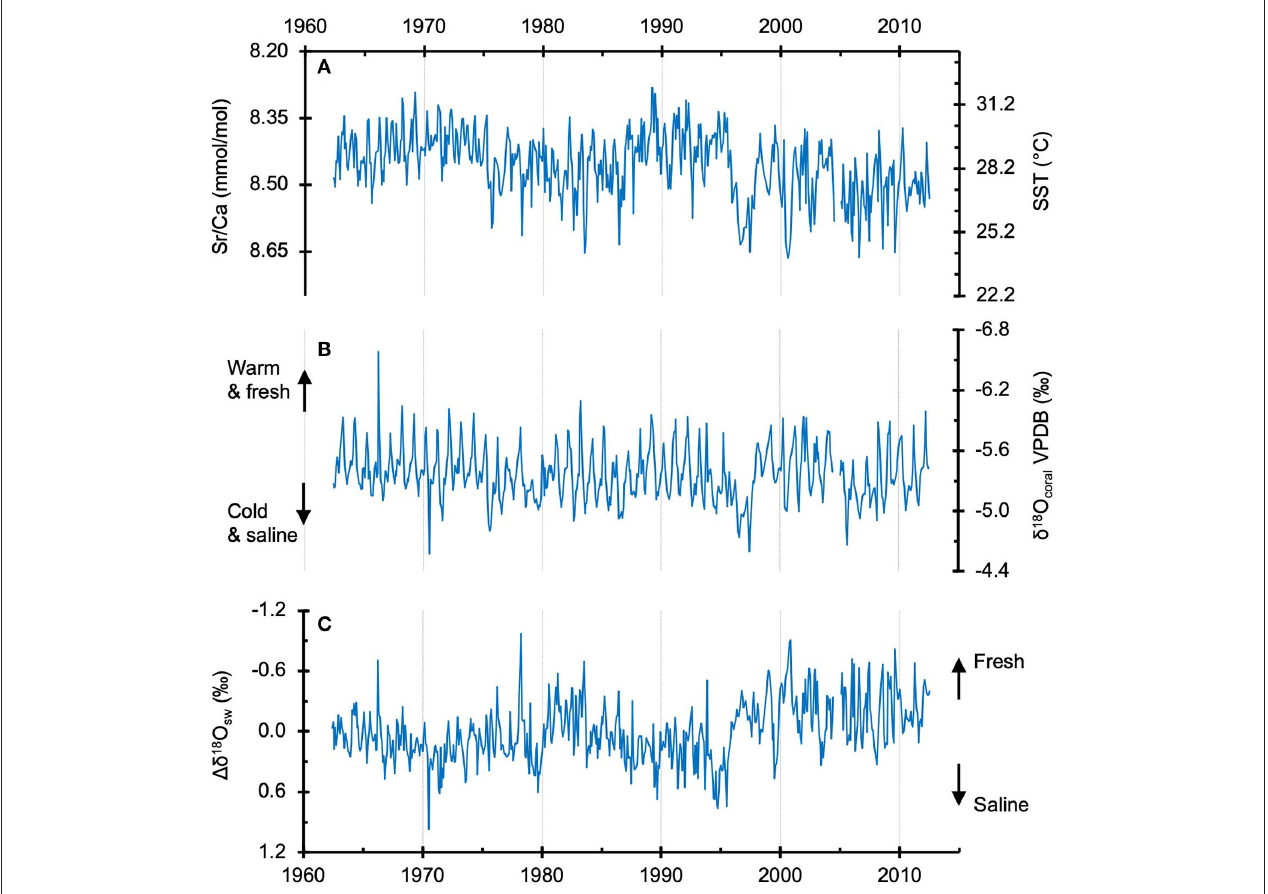
FIGURE 4 | Coral proxy data for the period 1962–2012 with monthly resolution. (A) Sr/Ca and SST, (B) δ 18 O coral in core BAL13-09, and (C) salinity proxy 1 δ 18 O sw estimated from Sr/Ca and δ 18 O coral . The axis of Sr/Ca, δ 18 O coral , and 1 δ 18 O sw is inverted.